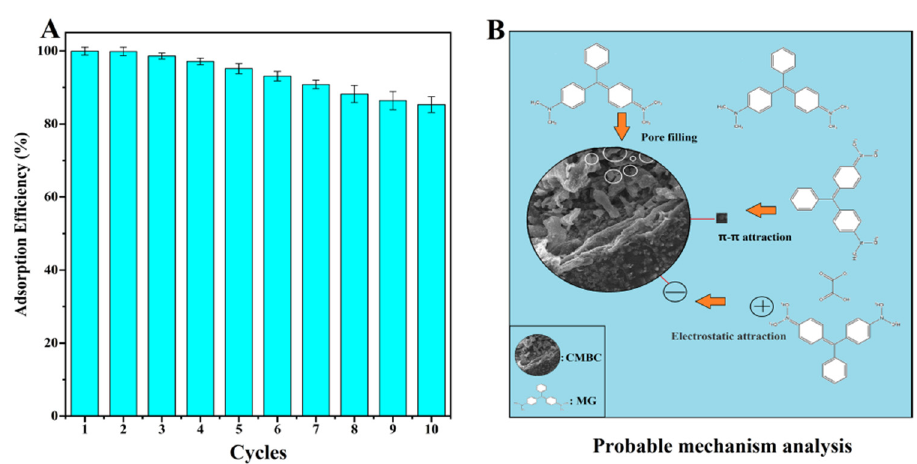
Figure 7. ( A ) The reusability and ( B ) probable mechanism analysis of CMBC-4-700-30 for removal of